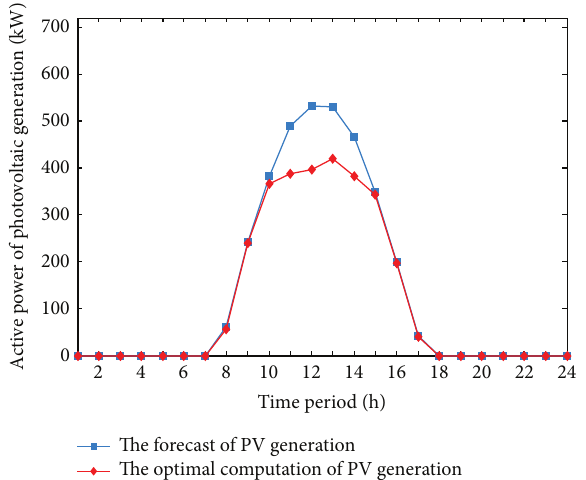
Figure 6: The comparison of forecasted PV value and the computed optimal PV value.